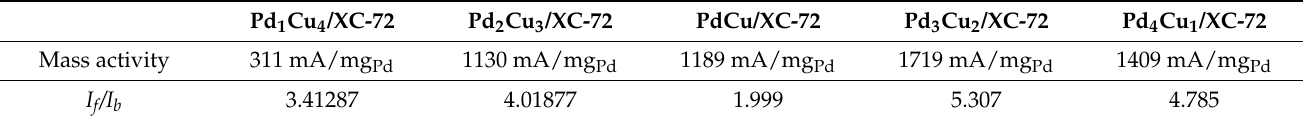
Table 3. Comparison of CO resistance of different